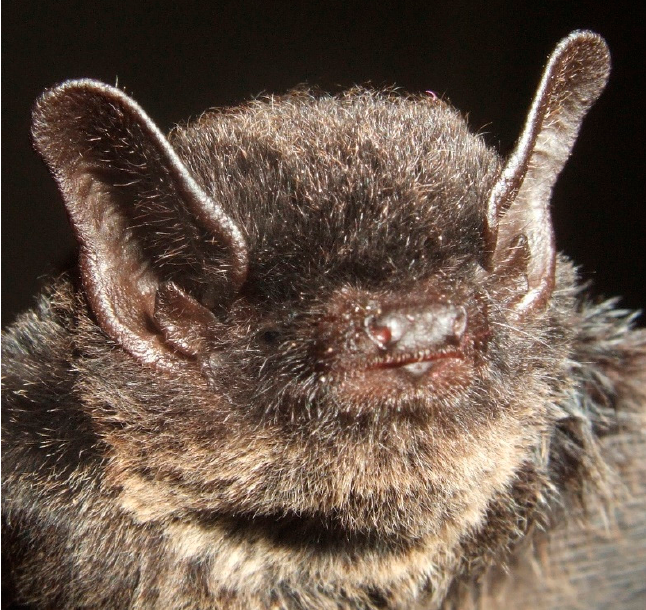
Figure 16. Hypsugo pulveratus , adult male. Photograph by Vu Dinh Thong.